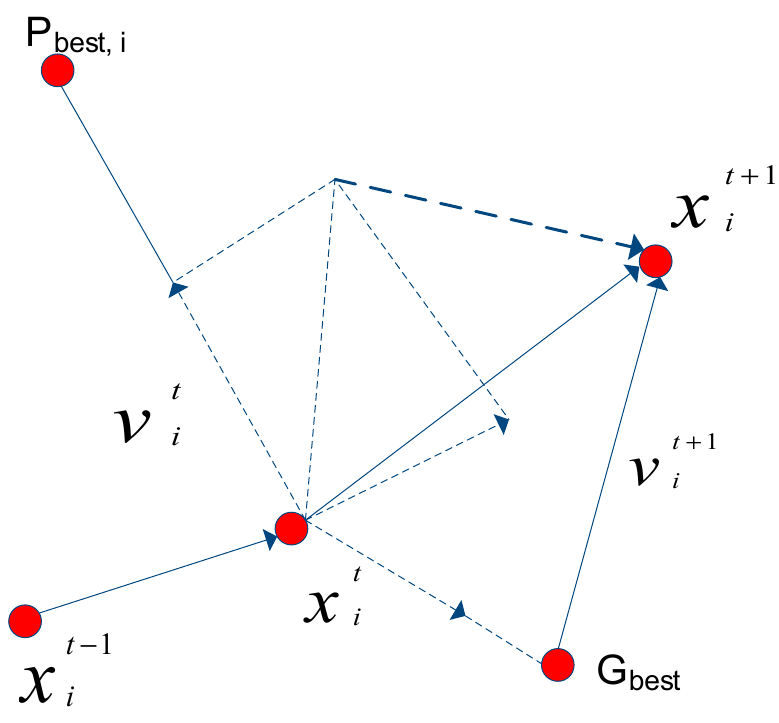
Figure 21. Movement of particles in a particle swarm optimization method [82 , 84].